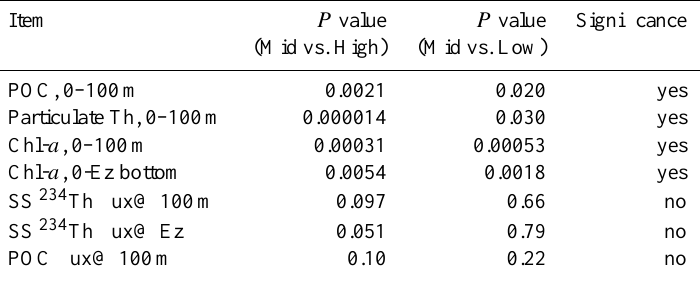
Table 3. P values derived from t-tests with unequal variance on inventories of POC, Particulate 234 Th and Chl- a , Steady-State (SS) 234 Th fluxes and POC fluxes at 100 m and euphotic zone (Ez) water depths for mid- vs. high salinity water and mid- vs. low salinity